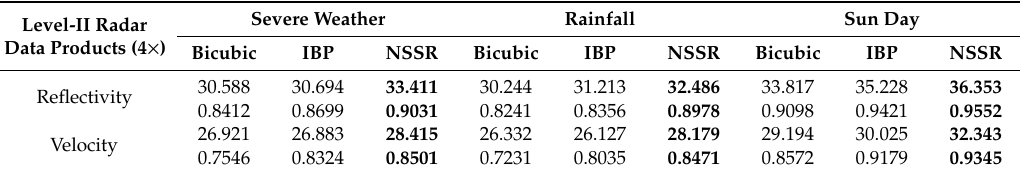
Table 3. Average PSNR (dB) and SSIM results of the reconstructed echo of five groups of level-II CINRAD SA